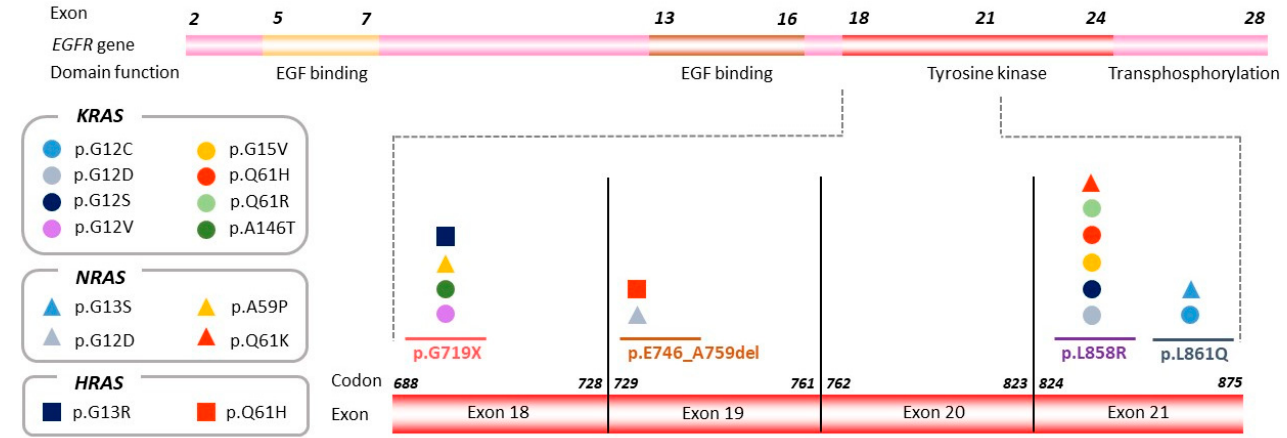
Figure 3. KRAS, NRAS , and HRAS mutations detected by NGS according to exon location of the original EGFR -sensitizing mutation. The EGFR gene is represented, and the region including exons 18–21 is magnified in order to show the distribution of KRAS , NRAS , and HRAS variants detected in the plasma sample upon disease progression (represented by circles, rectangles, and squares, respectively), according to exon location of the original EGFR sensitizing mutation.